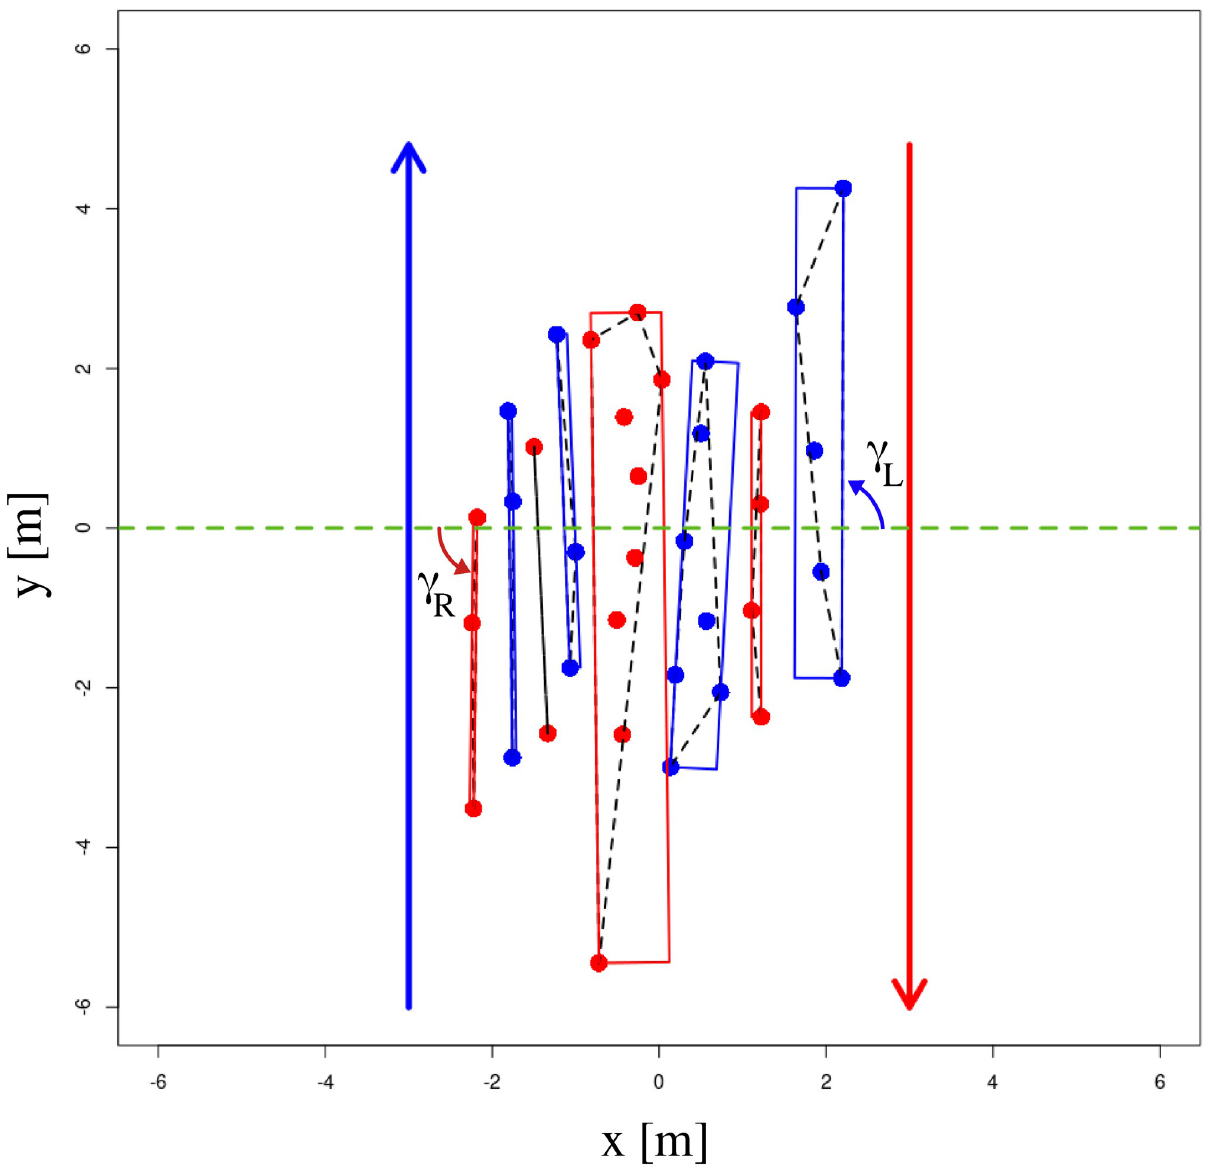
Fig 15. Stripes for a typical trial of counter flow. The red and blue dots denote the group of pedestrians that move along the direction of arrows shown in the same colors. The rectangular boxes in blue and red are minimum bounding boxes of the stripes that is used for per-stripe analysis. Individual stripe orientations γ and γ are also shown. The dashed green line indicates the bisector of the crossing angle. The dashed black lines L R enclosing each stripe are the convex hulls of pedestrian locations within that stripe. The stripe with 2 pedestrians was excluded from per-stripe